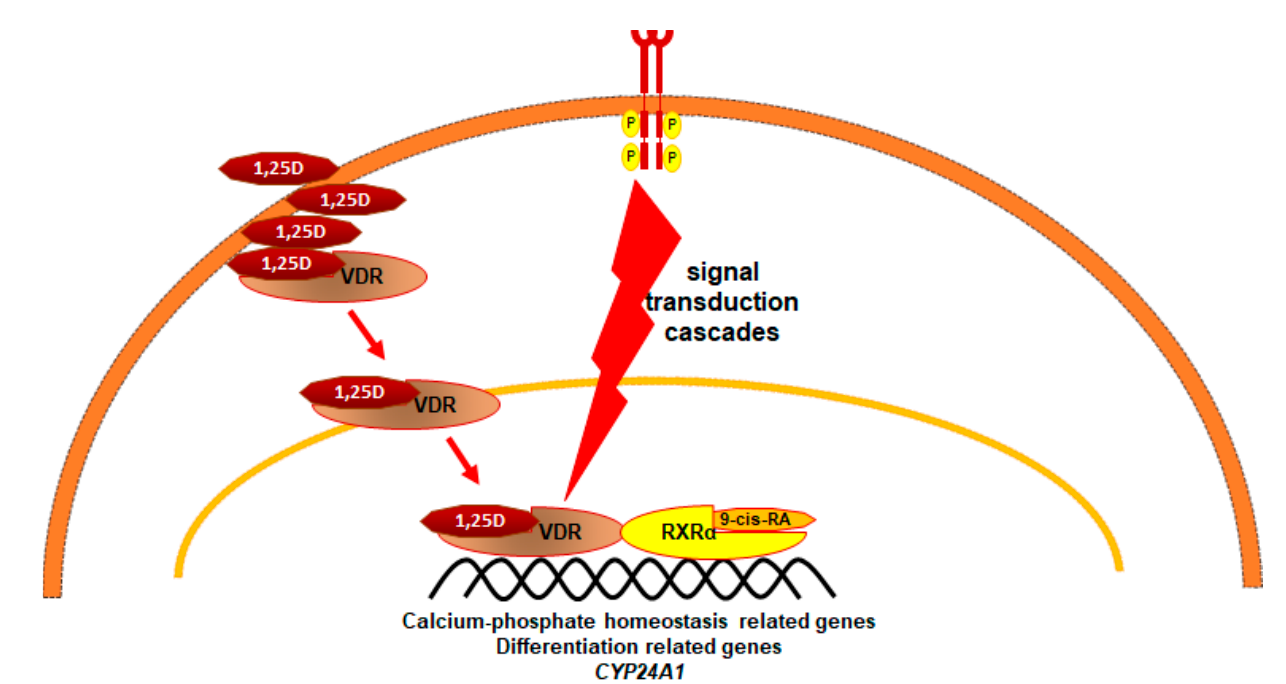
Figure 3. Vitamin D receptor (VDR) pathway. 1,25D translocates through the plasma membrane and binds to its receptor in the cytosol. Ligated VDR is transported to the cell nucleus, where it dimerizes with RXR α . VDR/RXR α complex binds to response elements in the DNA to regulate transcription of target genes. Signal transduction from membrane receptors participates in the activity and stability of VDR [47–49].